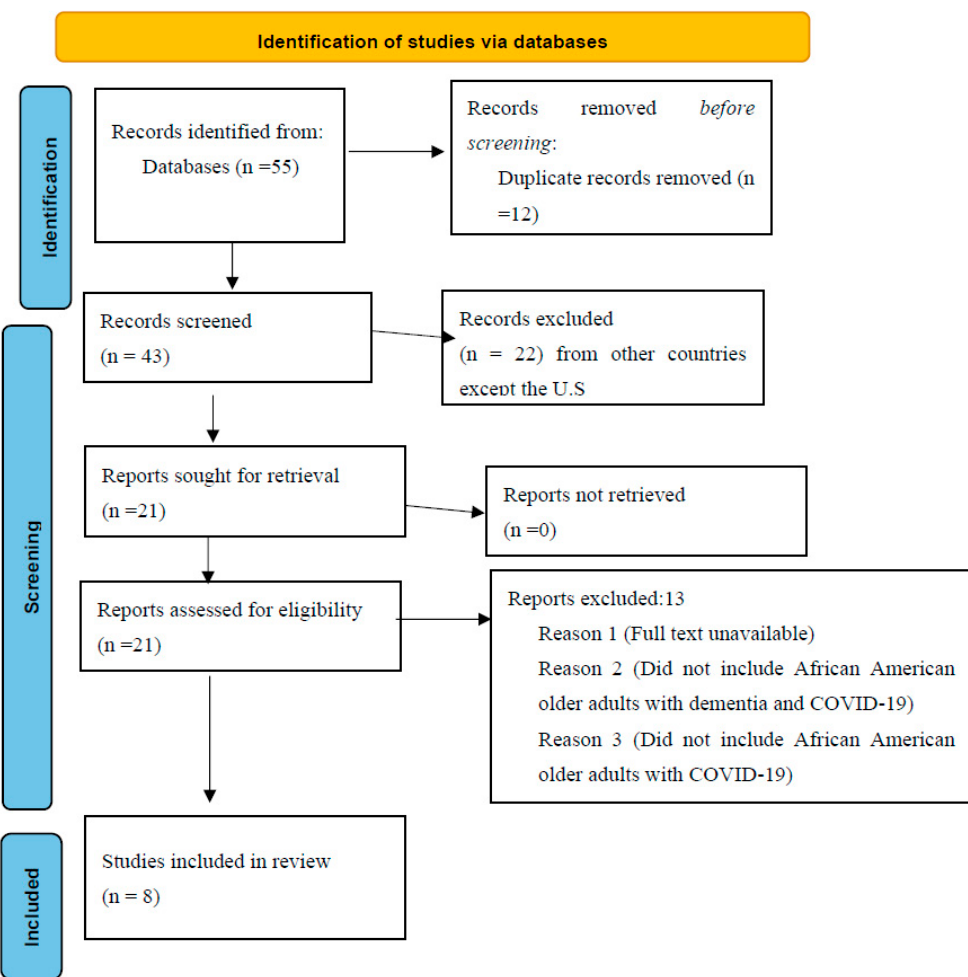
Figure 1. Flowchart showing the number of publications identified and screened for eligibility during the scoping review